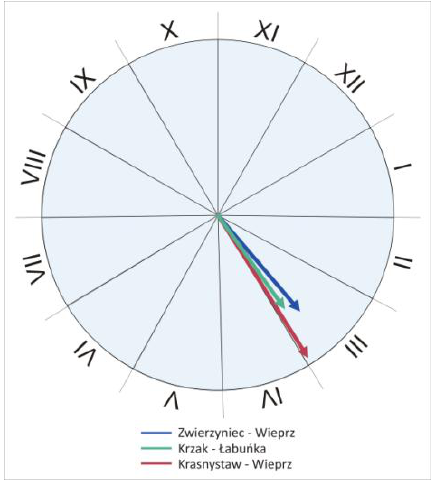
Fig. 3. Markham’s seasonality coefficients in upper Wieprz catchment standardised by subcatchment area